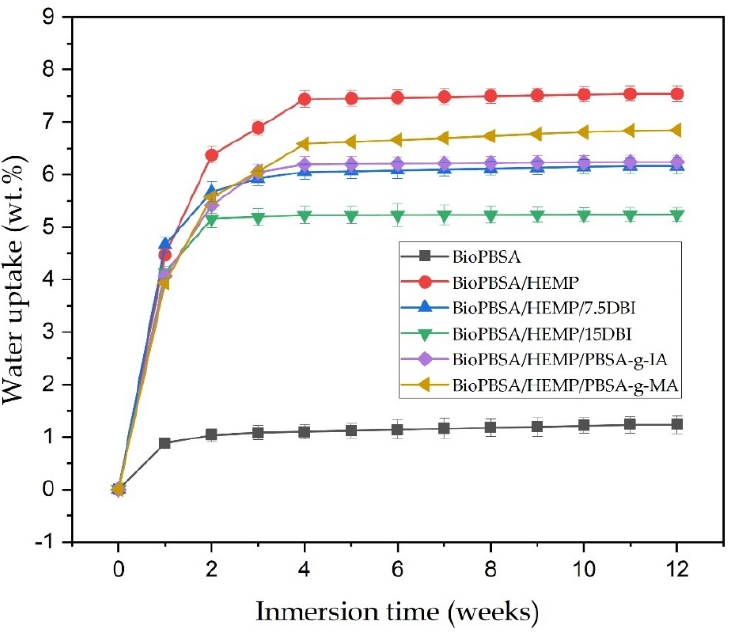
Figure 8. Water uptake of BioPBSA/HEMP composites after 12 weeks of immersion.